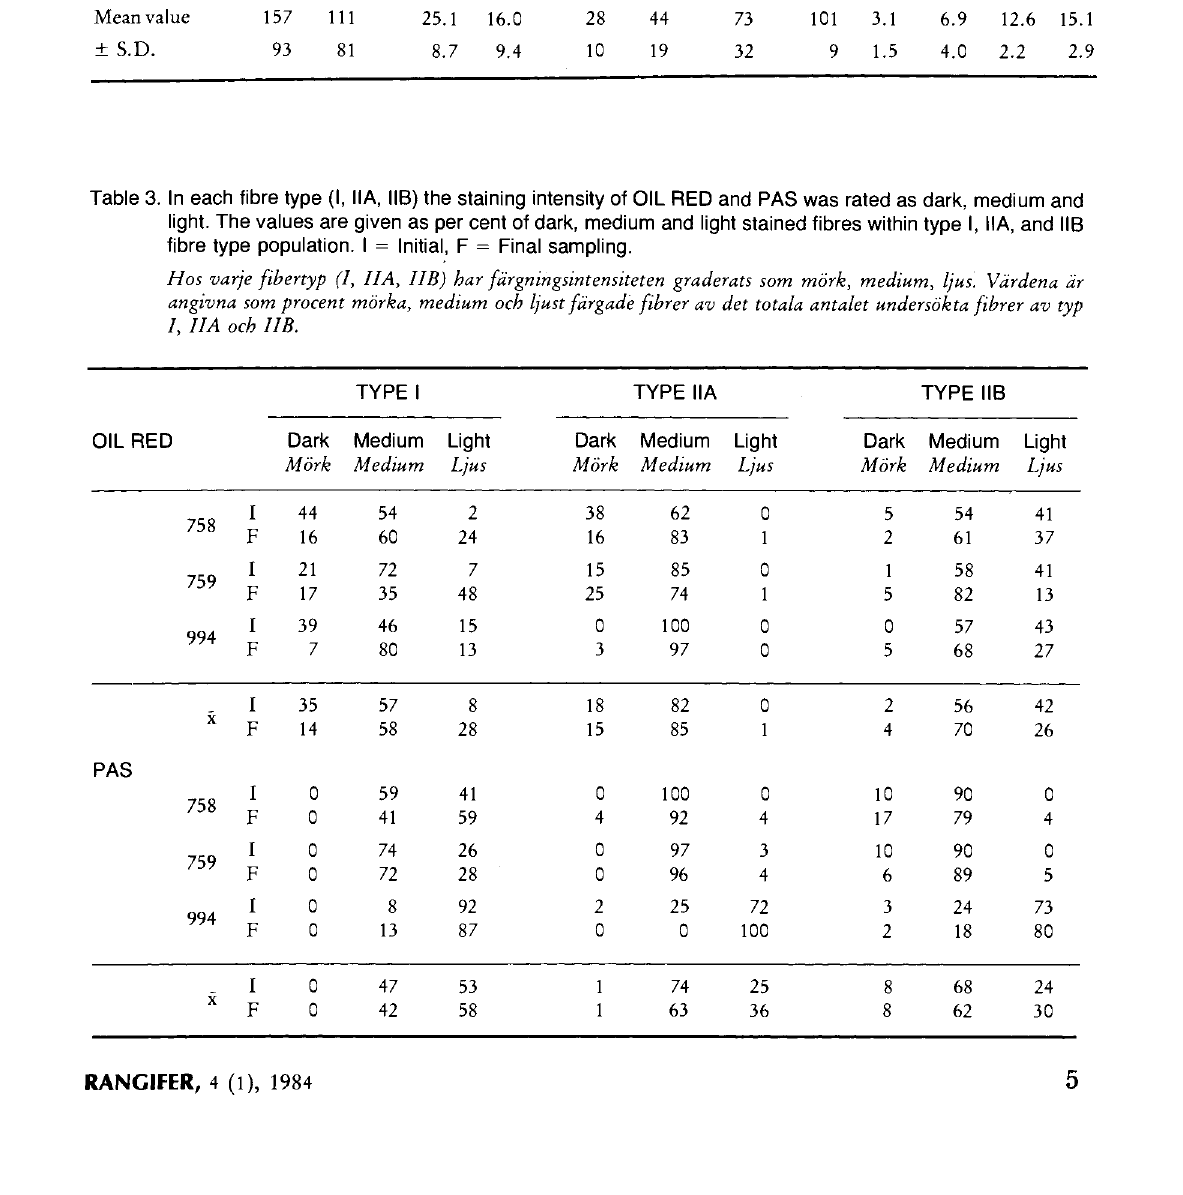
Table 2. Glycogen, triglyceride, lactate (umol/g) in semitendinosus muscle of stressed reindeer and Cortisol (nmol/l), ASAT (ukat/l) and urea (mmol) levels in blood. I = Initial, F = Final sampling. Glykogen, triglycerid, laktat (/xmol/g) i musculus semitendinosus bos stressade renar samt Cortisol (nmol/l), ASAT (fj.kat/1) och urea (mmol) i blod. I = Initialprovtagning, F = Slutlig provtagning. Glycogen Triglyceride Lactate Cortisol ASAT Urea